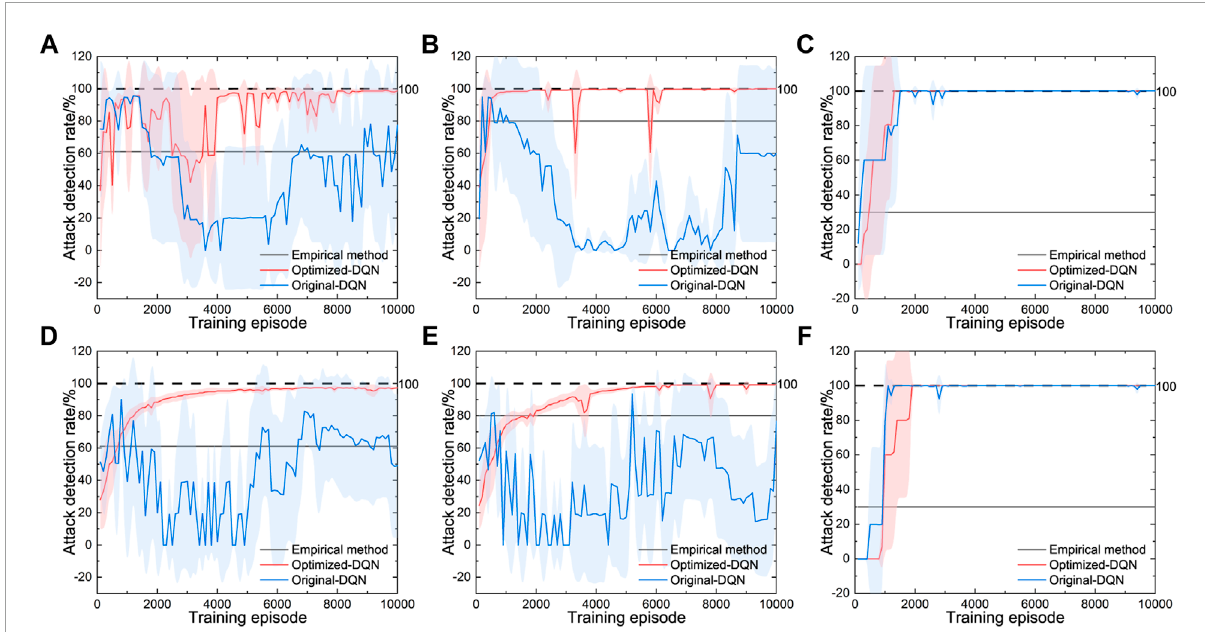
FIGURE 7 Detection with optimized-DQN, original-DQN and empirical method against attacks. (A) Detection with EKF against Attack-1, (B) Detection with EKF against Attack-2, (C) Detection with EKF against Attack-3, (D) Detection with UKF against Attack-1, (E) Detection with UKF against Attack-2 and (F) Detection with UKF against Attack-3.